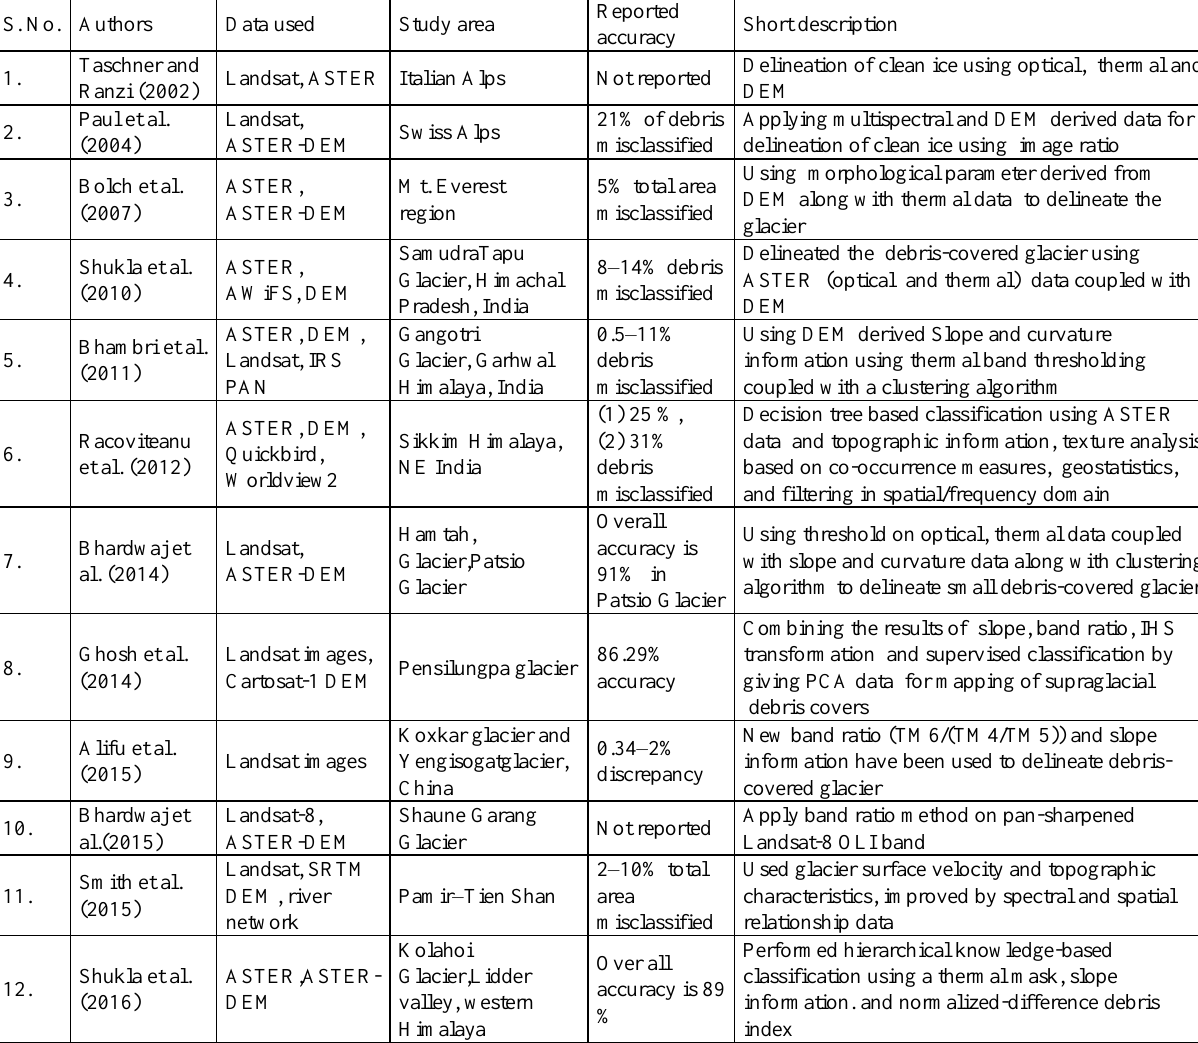
Table 1. Pixel-based method to delineate debris-covered